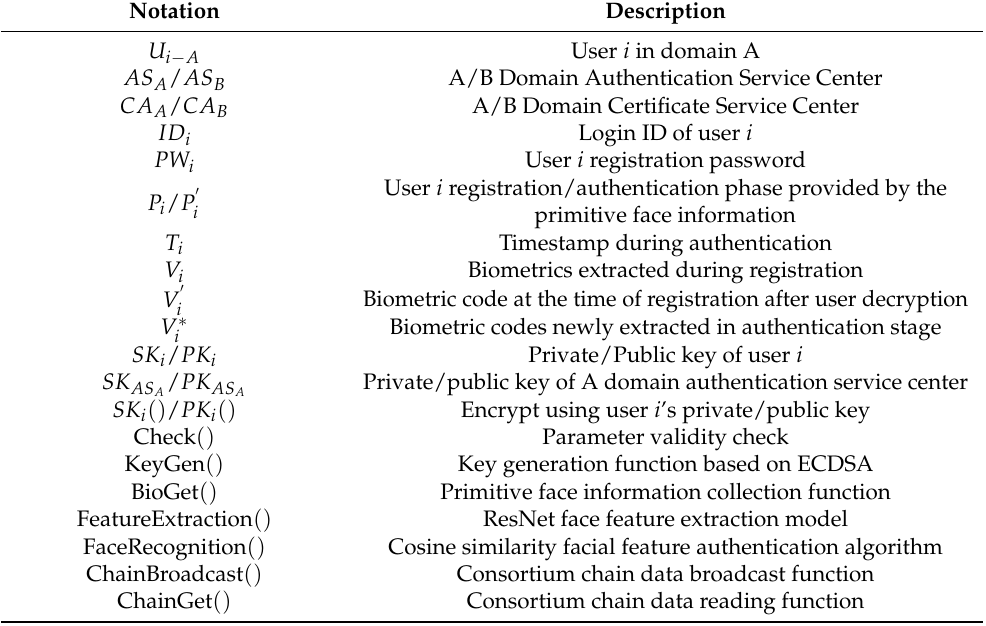
Table 1. Terminology